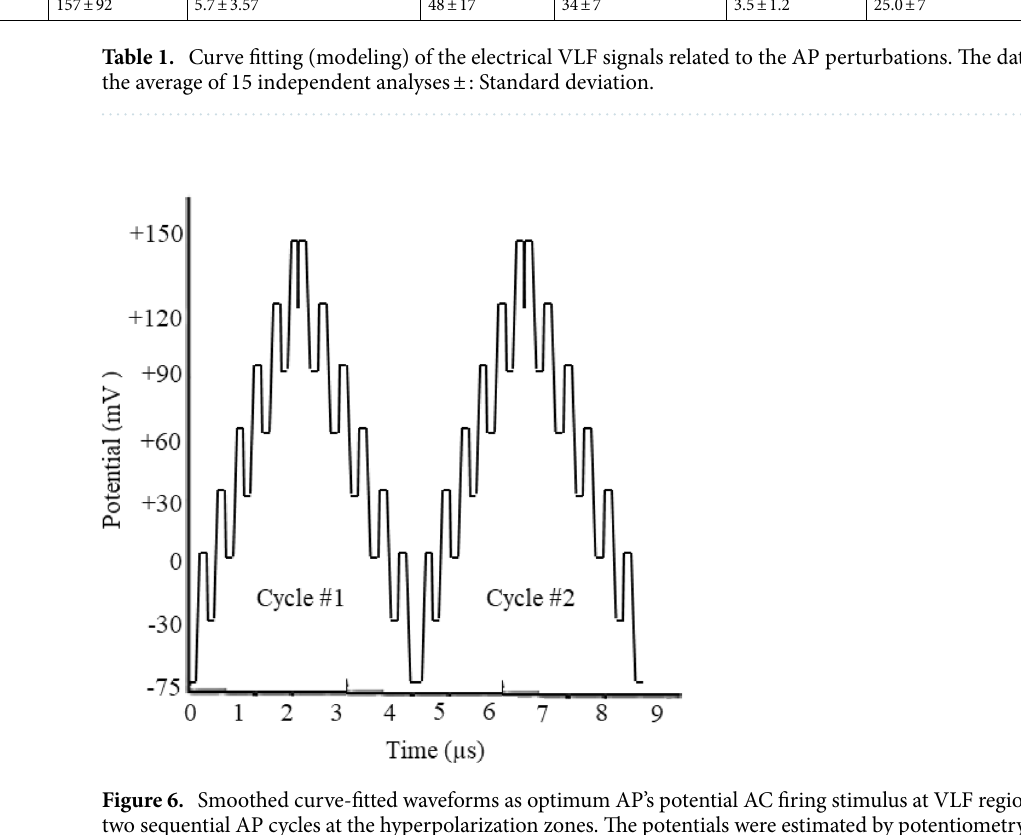
V p-p (mV, vs. total applied potential) Frequency (Hz)